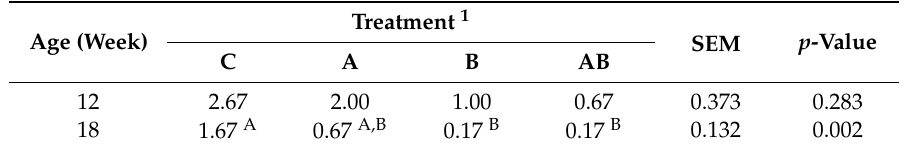
Table 4. E ff ect of the treatment on intestinal lesion score in Kuroiler chickens, reared under tropical climatic conditions, naturally infected with Eimeria